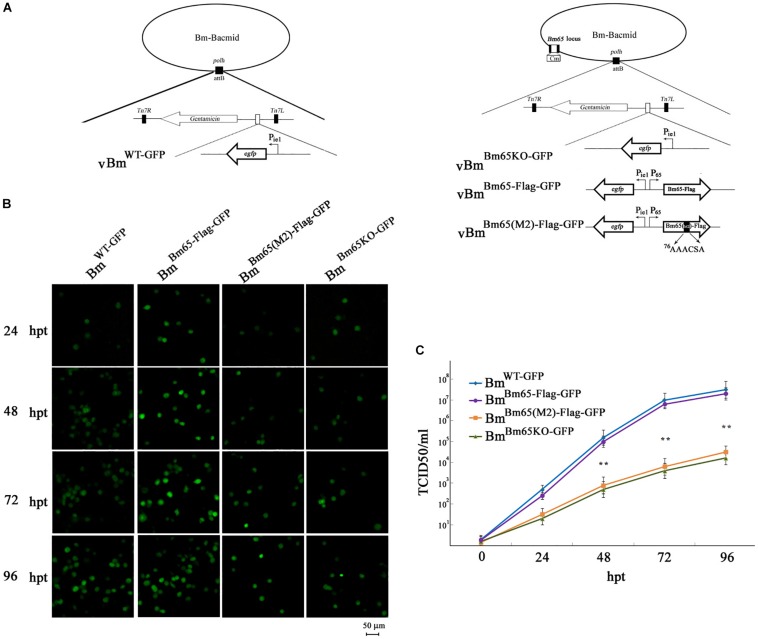
Analysis of viral replication in BmN cells. (A) Strategy for the construction of vBmWT–GFP, vBmBm65–Flag–GFP, vBmBm65KO–GFP and vBmBm65(M2)–GFP. (B) Fluorescence microscopy of BmN cells transfected with BmWT–GFP, BmBm65–Flag–GFP, BmBm65KO–GFP, and BmBm65(M2)–Flag–GFP at 24, 48, 72, and 96 hpt. The time after transfection was indicated on the left. (C) Virus growth curves generated from BmN cells transfected with BmWT–GFP, BmBm65–Flag–GFP, BmBm65KO–GFP, and BmBm65(M2)–GFP. Transfection supernatants were harvested at selected time points and used for infectivity assays by the determination of TCID50. Each datum point represents the average value derived from three independent experiments (n = 3). Error bars indicate standard deviations. ∗∗ Indicates a statistically significant difference (P < 0.01).